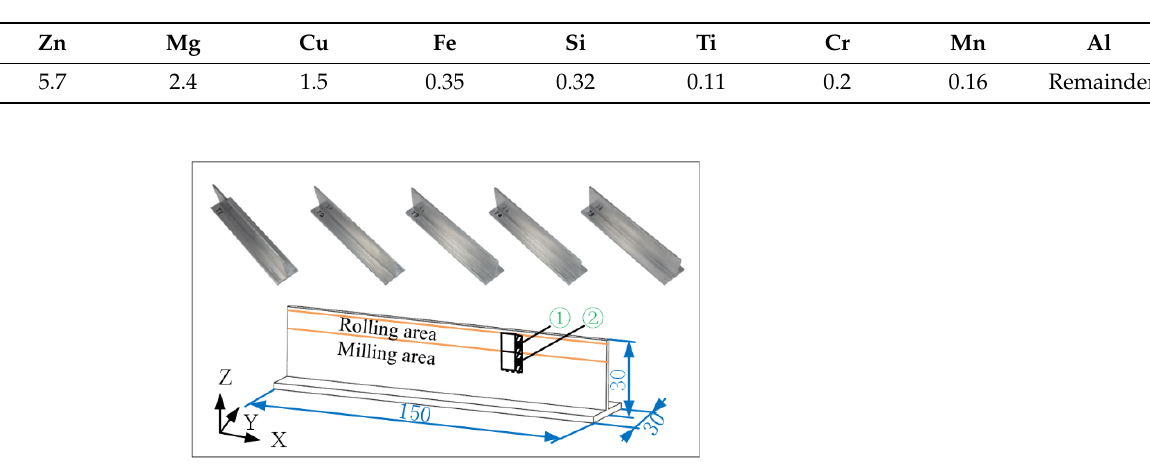
Figure 1. Samples used in the test.